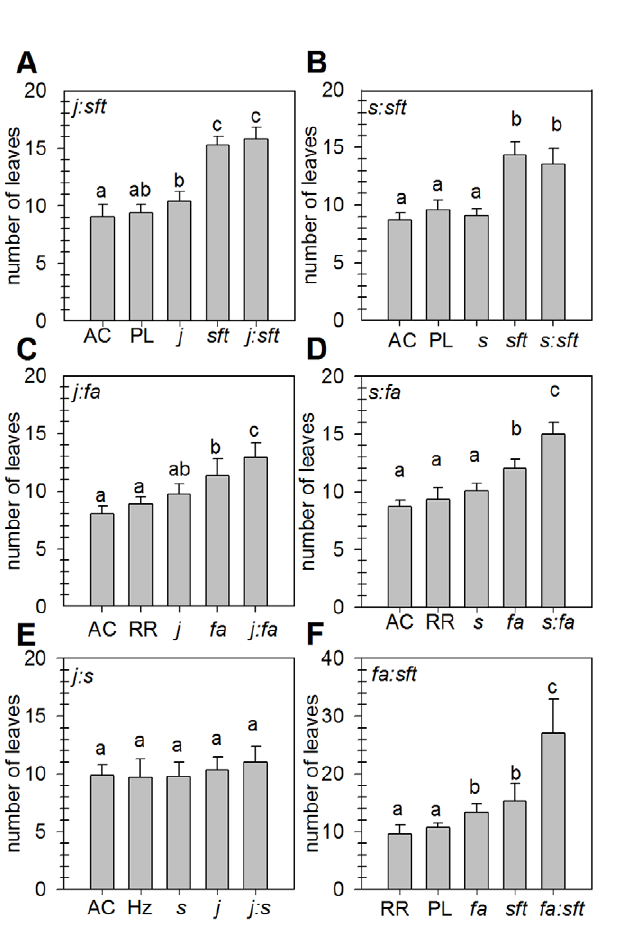
affect flowering time alone, the j:s double mutant always produced one more leaf than the parental mutants (Figure 1E). flowering, reflecting a synergistic effect of fa and sft mutations